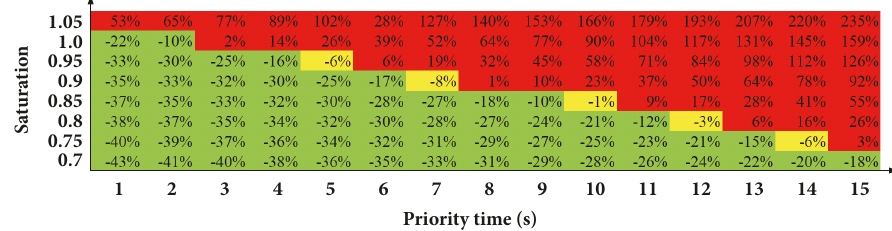
Figure 14: Table with recommended values for bus signal